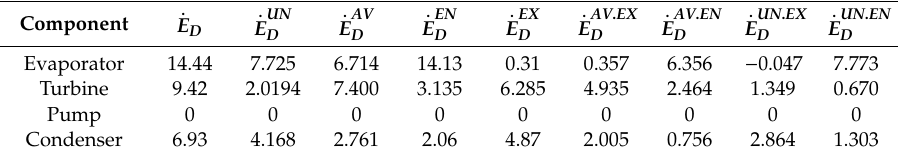
Table 8. Advanced exergy analysis results (kW) for BORC.